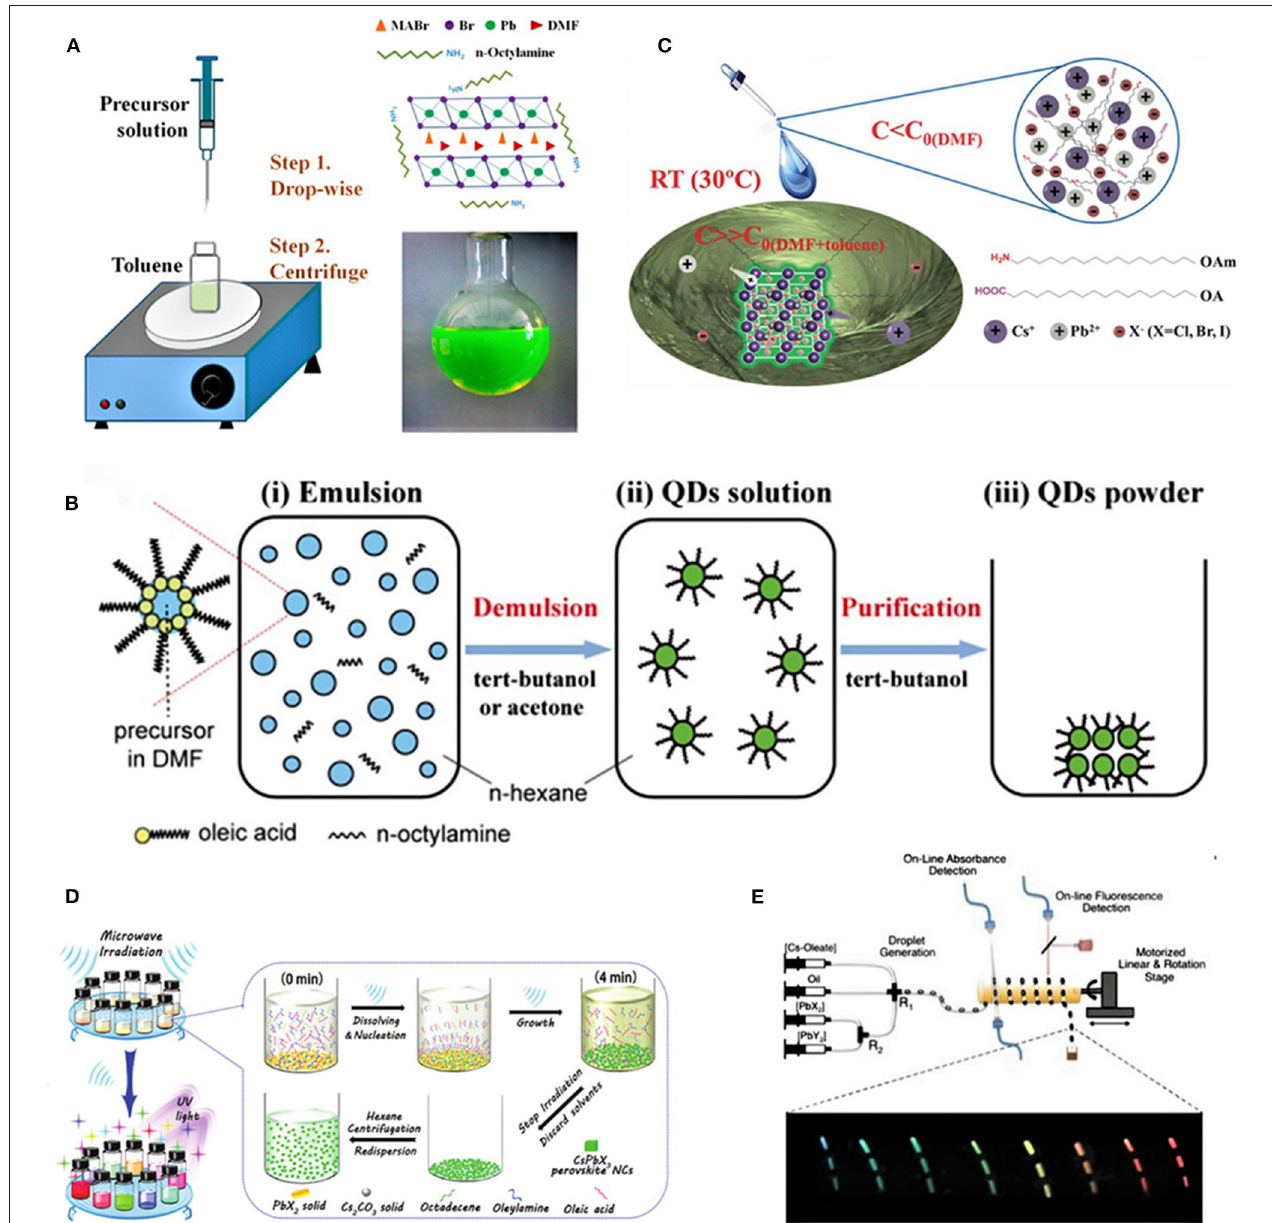
FIGURE 1 | (A) Schematic illustration of the synthesis procedures for the ligand-assisted reprecipitation (LARP) process (Zhang et al., 2015). Reproduced with permission. Copyright 2015, American Chemical Society. (B) Emulsion synthesis (Huang et al., 2015). Reproduced with permission. Copyright 2015, American Chemical Society. (C) Supersaturated recrystallization (Li et al., 2016). Reproduced with permission. Copyright 2016, Wiley-VCH Verlag GmbH & Co. KGaA, Weinheim. (D) Microwave irradiation (Long et al., 2017). Reproduced with permission. Copyright 2017, Royal Society of Chemistry. (E) Microfluidic reaction (Lignos et al., 2016). Reproduced with permission. Copyright 2016, American Chemical